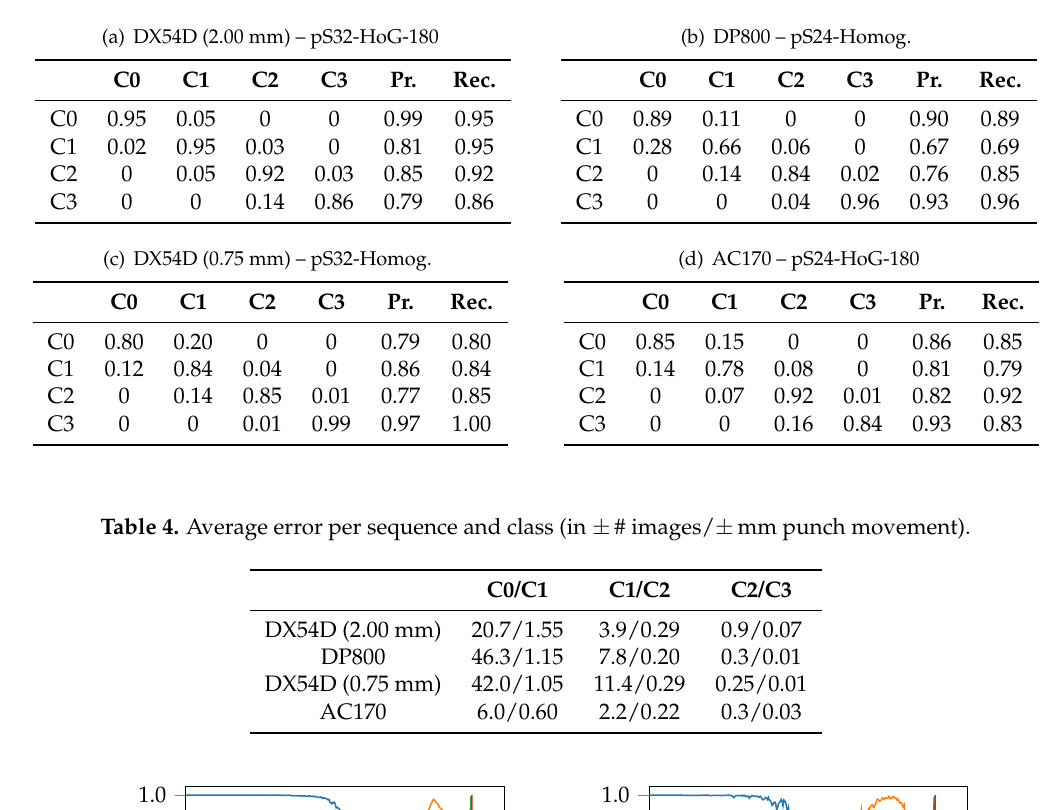
# images/ mm punch movement). ± ±